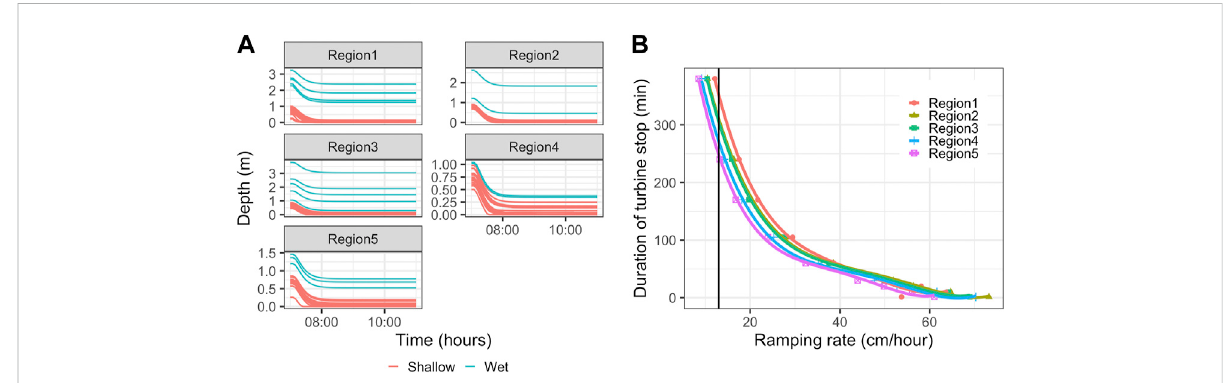
FIGURE 7 Reductionindepthcomputedforspeci fi clocationsalongtheriver (A) andtherelationshipbetweendewateringratesandtimefromastopinthe hydropower plant (B) . The black line in panel (B) shows the threshold for stranding.